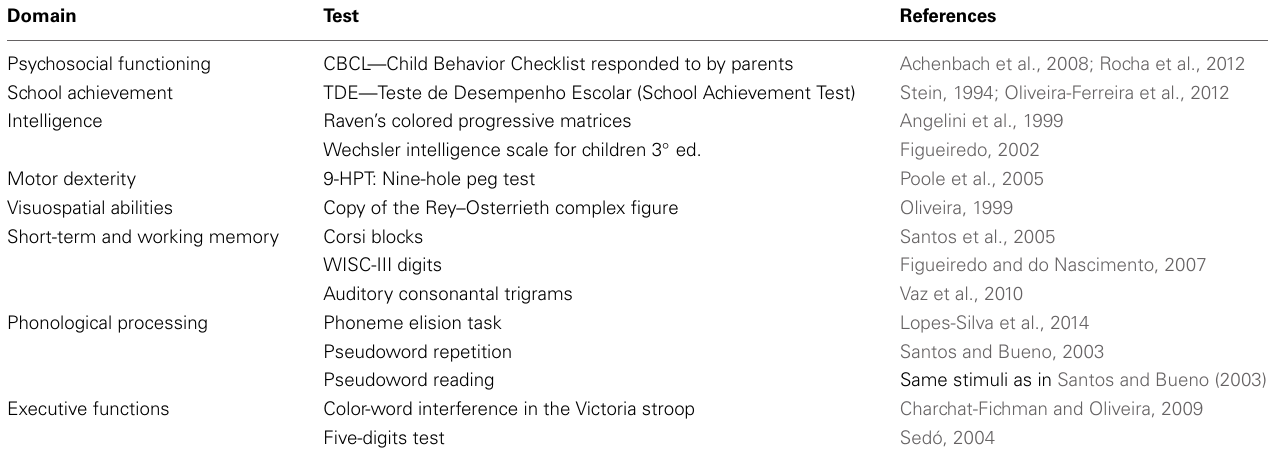
Table 1 | Neuropsychological